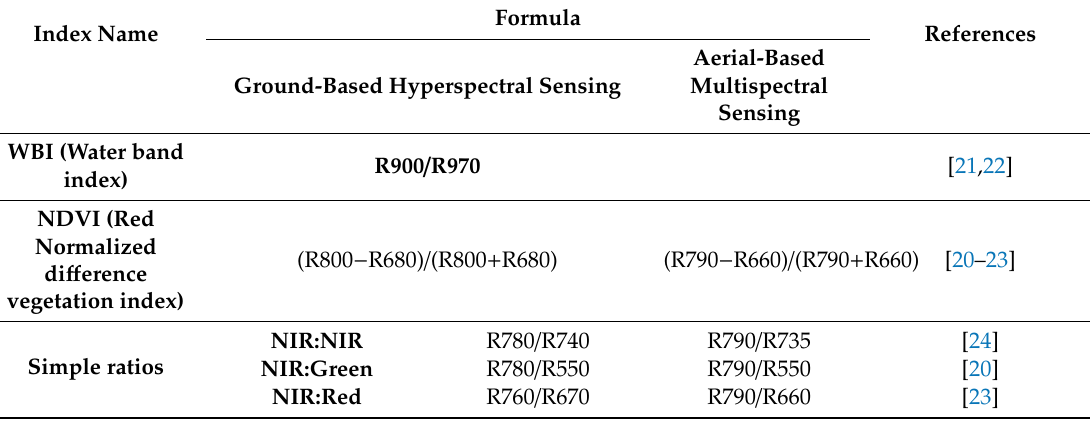
Table 1. Spectral reflectance indices used in this